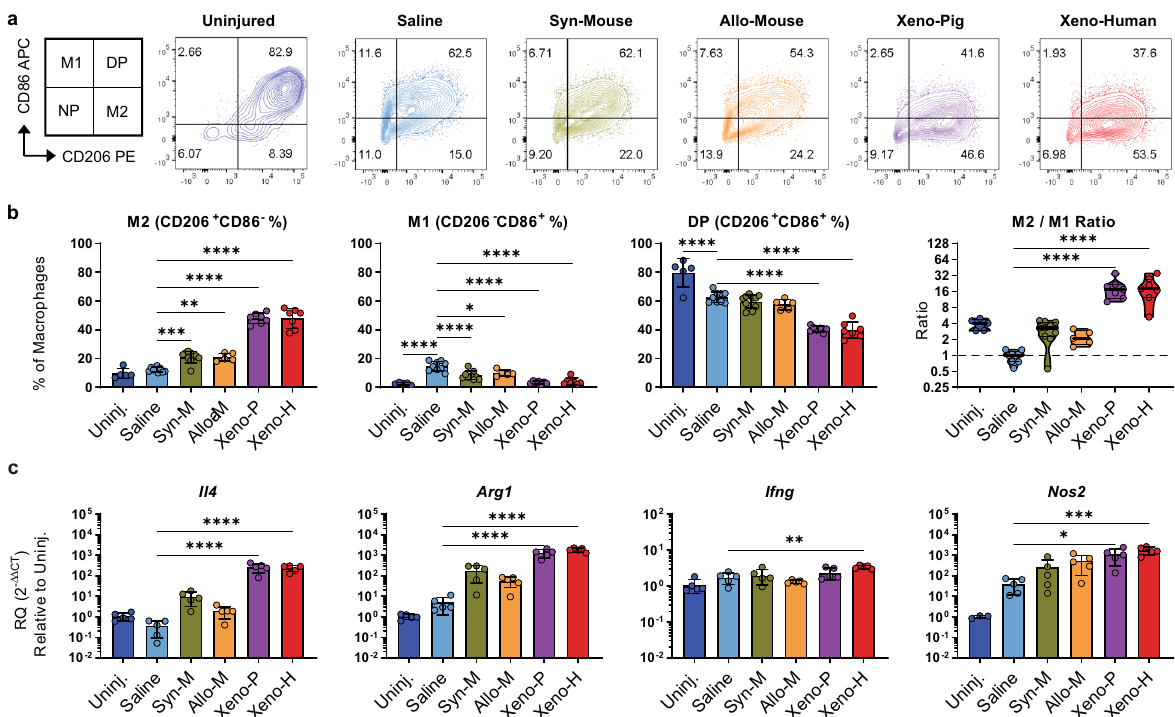
Fig. 4 AAT scaffolds skew macrophages towards an M2-phenotype in muscle wounds. a CD206 and CD86 expression in macrophages (CD45 + SiglecF - CD11b + CD3 - Ly6g − Ly6c − F4/80 + ) isolated from healthy quadriceps muscle and scaffold- or saline-treated muscle wounds after 1-week post-op. b Populations of alternately activated “ M2 ” (CD206 + CD86 − ), classically activated “ M1 ” (CD206 − CD86 + ), double-polarized (CD206 + CD86 + ) and nonpolarized (CD206 − CD86 − ) macrophages quanti fi ed by fl ow cytometry. c Expression of canonical M2 ( Il4 , Arg1 ) and M1 ( Ifng , Nos2 ) genes at the wound site by qRT-PCR. Signi fi cance relative to vehicle control is depicted ( p -values), see Supplementary Table 2 for other signi fi cance values: * < 0.05, ** < 0.01, *** < 0.001, **** < 0.0001. Error bars represent ±1 standard